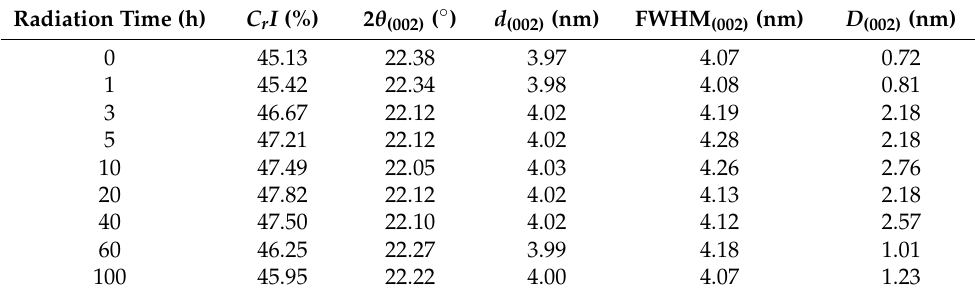
Figure 1. XRD curves of dyed wood powder during UV irradiation. Table 1. Crystallization parameters of dyed wood during UV